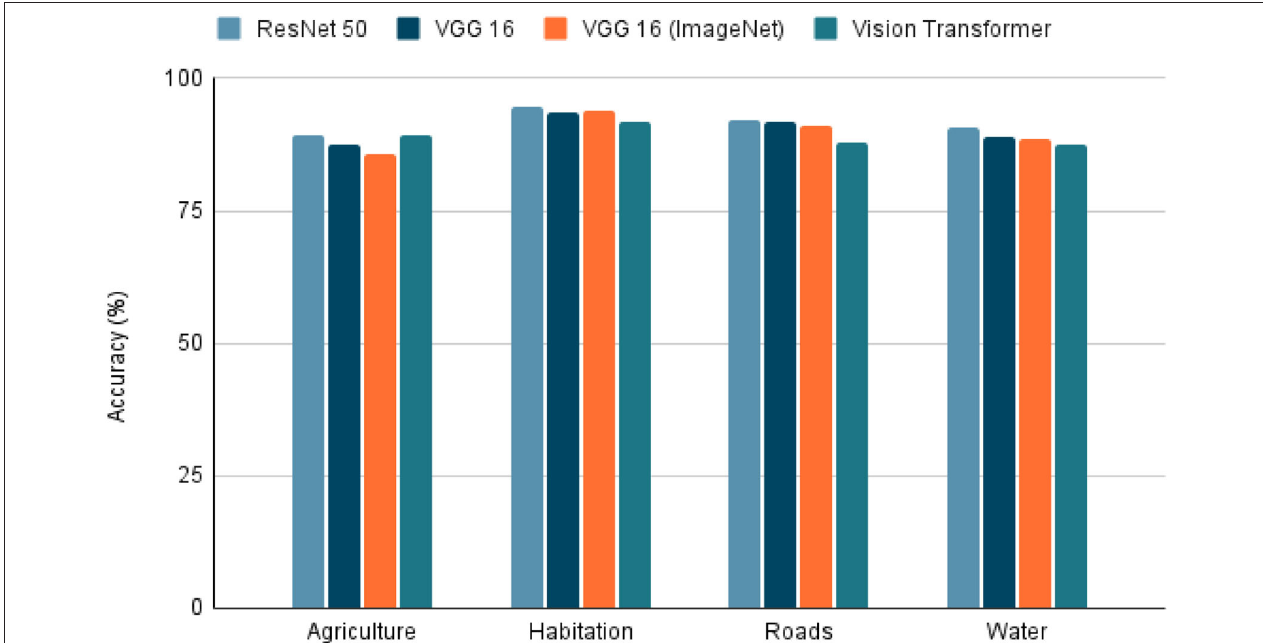
FIGURE 5 | Accuracy on tested models. Accuracy of the 4 models tested in the extraction of the 4 characteristics (agriculture, habitation, roads, whater). A highest value indicates a better performance in the classification task.